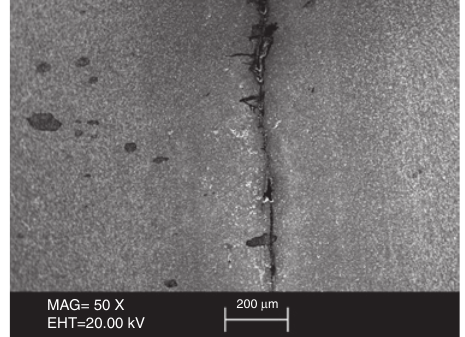
Figure 9 SEM microstructure image of the N4